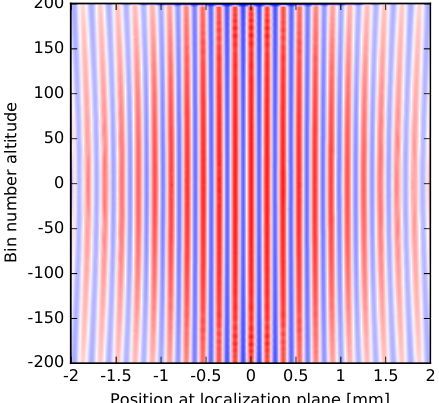
Figure 6. Simulated interferogram for a focused configuration con- sidering wave aberrations.